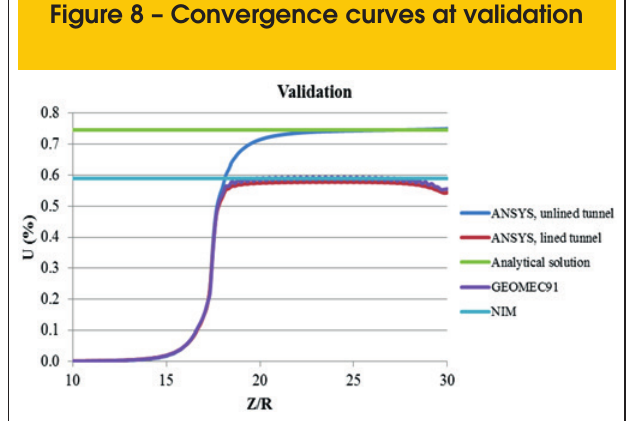
at validation for unlined